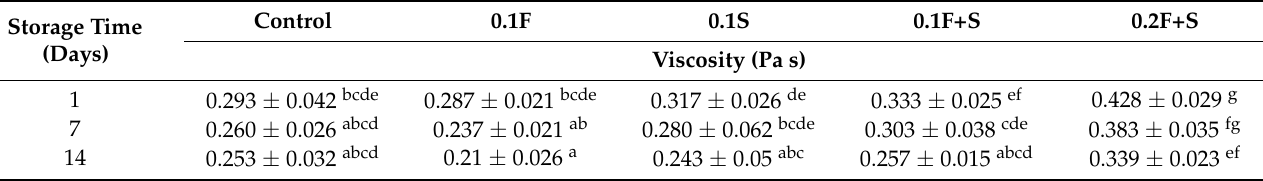
Table 4. Viscosity changes of yoghurt samples during